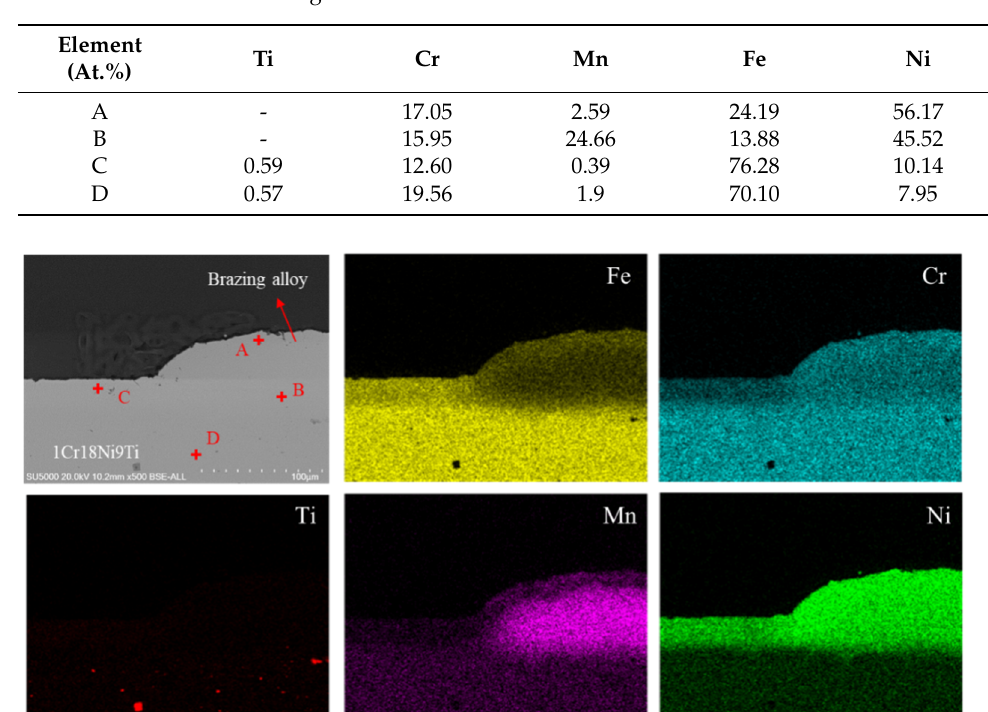
Figure 7. SEM image and the corresponding element map distribution of brazing alloy on substrates of acid treatment at 1170 °C/25 min. Table 3. The EDS results in Figure 7.